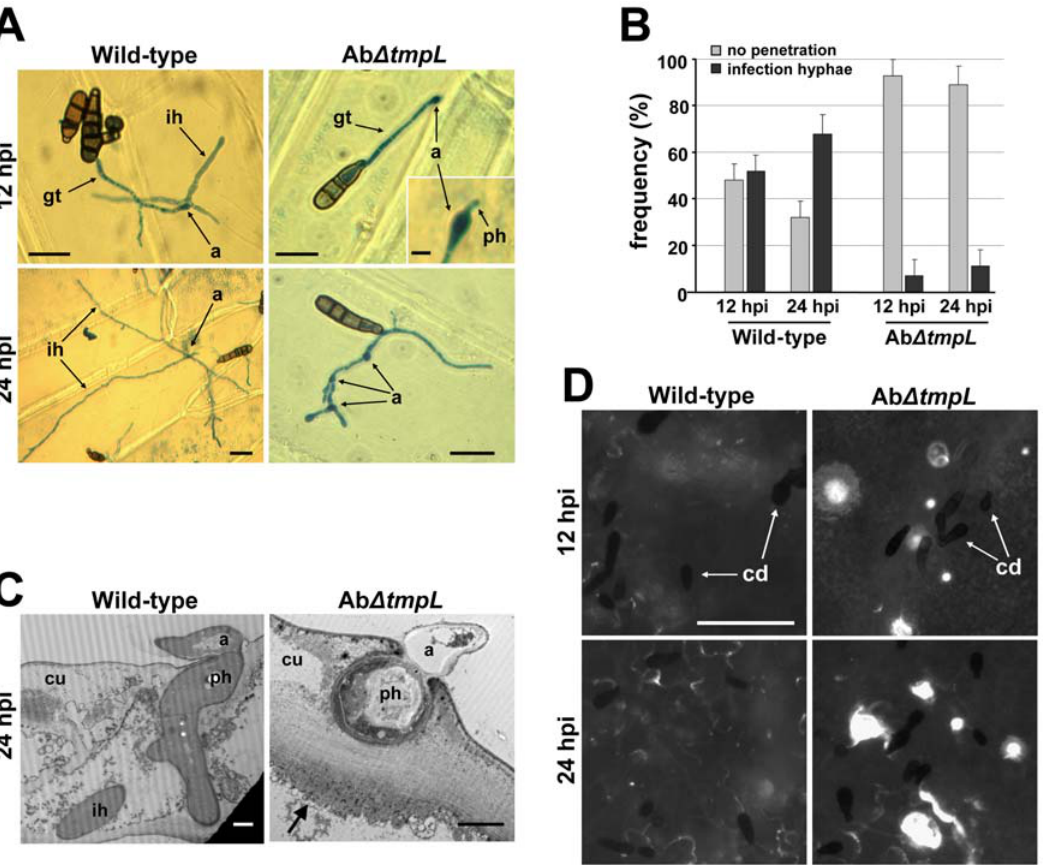
Figure 10. Appressoria and infection hyphae formation, ultrastructure, and callose detection assays of A.brassicicola D tmpL mutant infection. ( A ) Light micrographs of onion epidermis inoculated with A. brassiciola wild-type and D tmpL mutants at 12 and 24 hpi. Note that penetration hyphae (inset) were frequently visible under the mutant appressoria, but no further development was observed in the Ab D tmpL mutant infection. Bars=20 m m, except for the inset where it denotes 5 m m. Abbreviations: a, appressorium; gt, germ tube; ih, infection hypha; ph, penetration hypha. ( B ) Frequency of infection hyphae formation beneath appressoria of the A. brassicicola wild-type and D tmpL mutants on onion epidermis. Columns and error bars represent average and SD, respectively, of four independent experiments. ( C ) Transmission electron micrographs showing transverse sections of green cabbage leaves inoculated with A. brassicicola wild-type and D tmpL mutants. Leaves were collected at 24 hpi and prepared for transmission electron microscopy. Arrow indicates papilla formation (callose deposition) around a fungal penetration hypha. Bars=2 m m. Abbreviations: a, appressorium; cu, cuticle layer; ih, secondary infection hypha; ph, penetration hypha. ( D ) Callose deposition on green cabbage cotyledons inoculated with A. brassicicola wild-type and D tmpL mutants. White spots indicate callose deposition of the inoculation sites stained by aniline blue and viewed by epifluorescence microscopy. The tiny black spots dispersed on plant surface are fungal conidia (cd). Bars=50 m